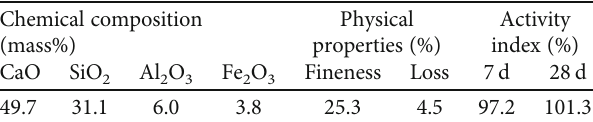
Table 2: Properties of